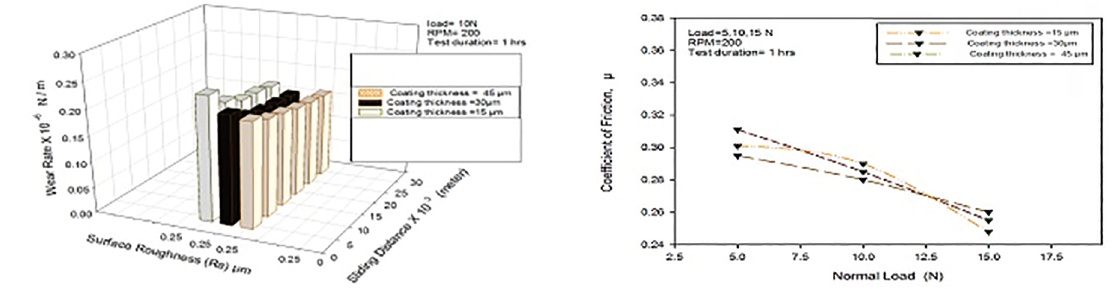
Figure 3. Wear rate with sliding distance. Figure 4. Friction coefficient with